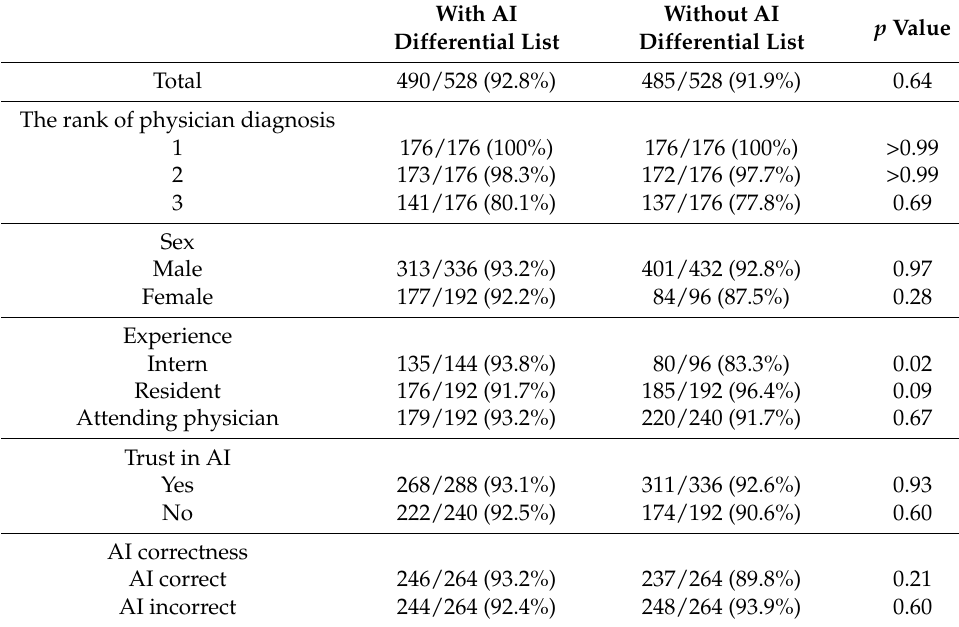
Table 1. The fill rates of answer boxes with physician diagnoses.